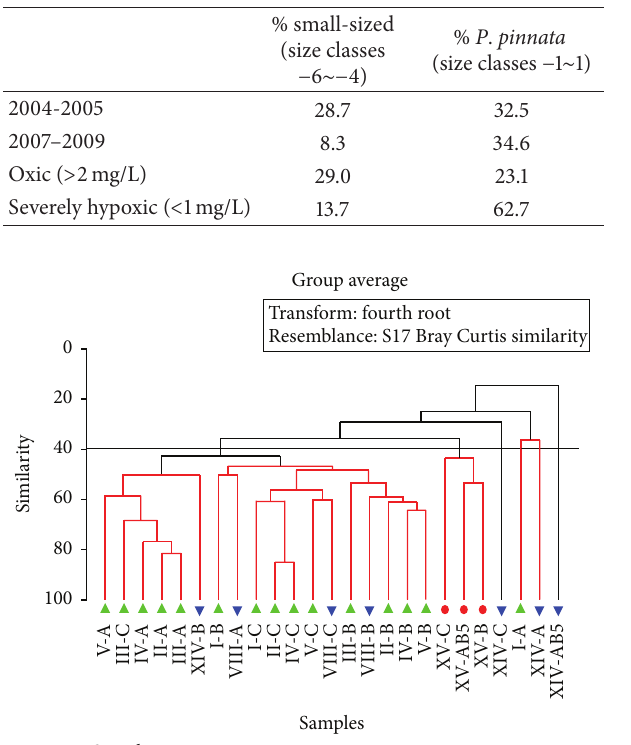
Table 2: Percentage of small-sized polychaetes and P . pinnata under different times and conditions relative to total abundance.